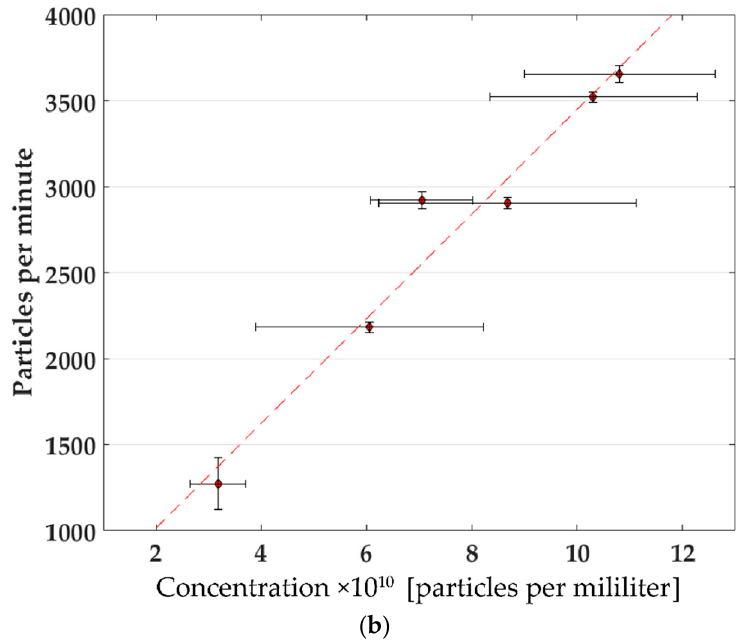
Figure 2. ( a ) Particles per minute measured with the microfluidic detector (red and green) and concentration of lipid nanoparticles in the collected product stream measured by the NanoSight system (blue). Error bars represent the standard errors of the respective measurement techniques. ( b ) Correlation of the microfluidic measured particles per minute and concentration.